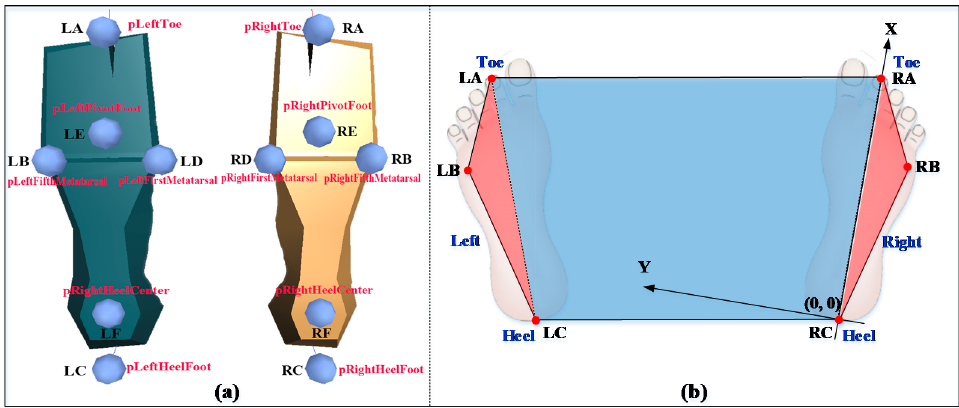
Figure 3. ( a ) Landmarks of foot soles in biomechanical model of MVN Studio; ( b ) Xsens-based BOS. Table 2. Base of Support (BOS) measures from Xsens MVN biomechanical model.